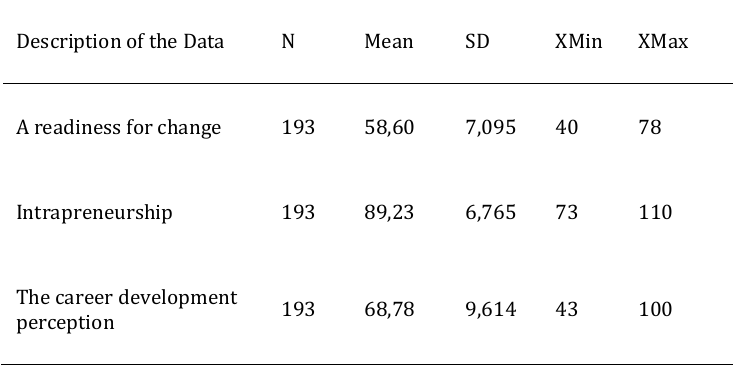
Table 7 The description of the research